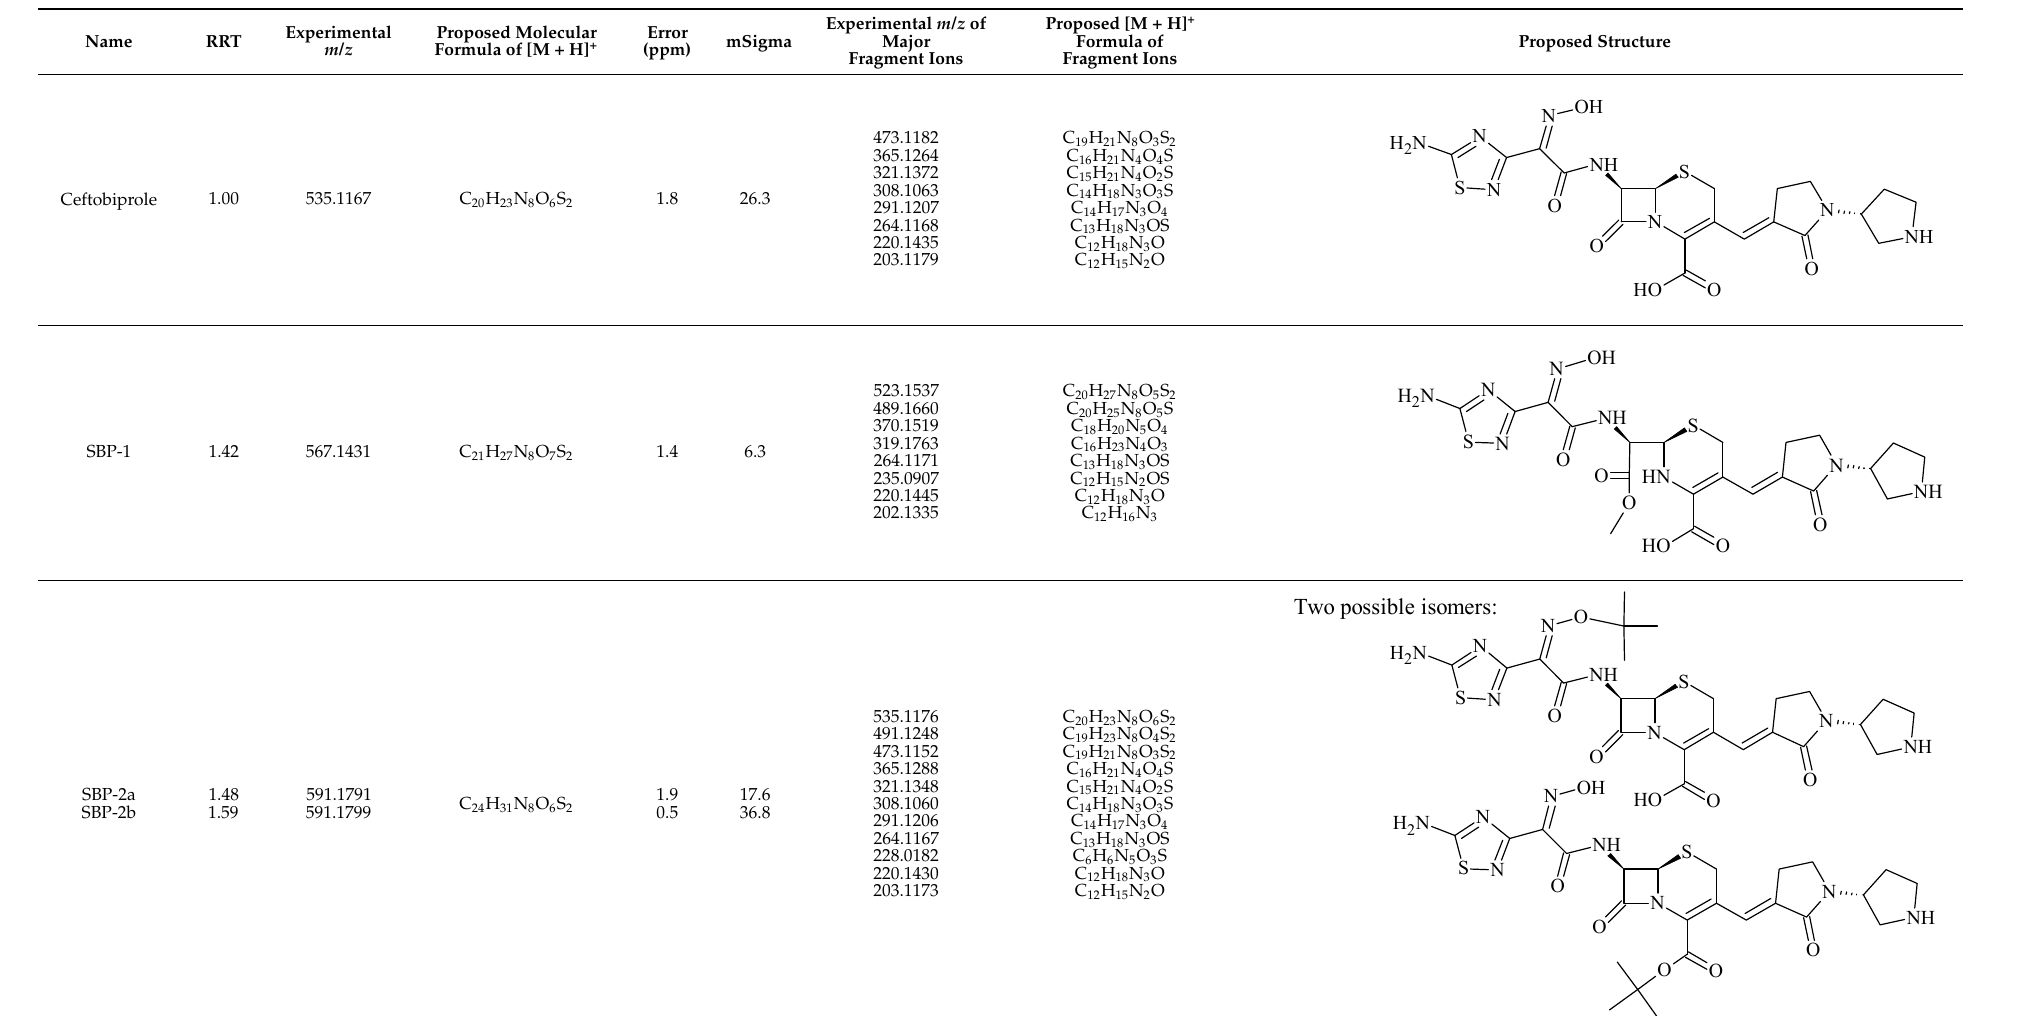
Table 5. Summary of mass spectrometric data for ceftobiprole and its SBPs and DPs.